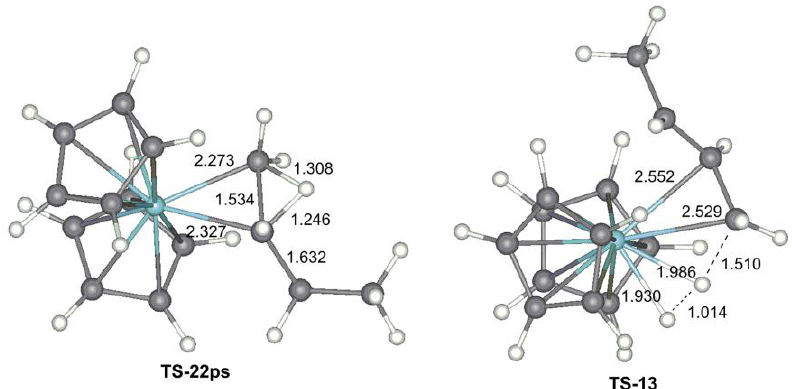
Figure 2. Optimized geometries of the transition states TS-22ps and TS-13 .